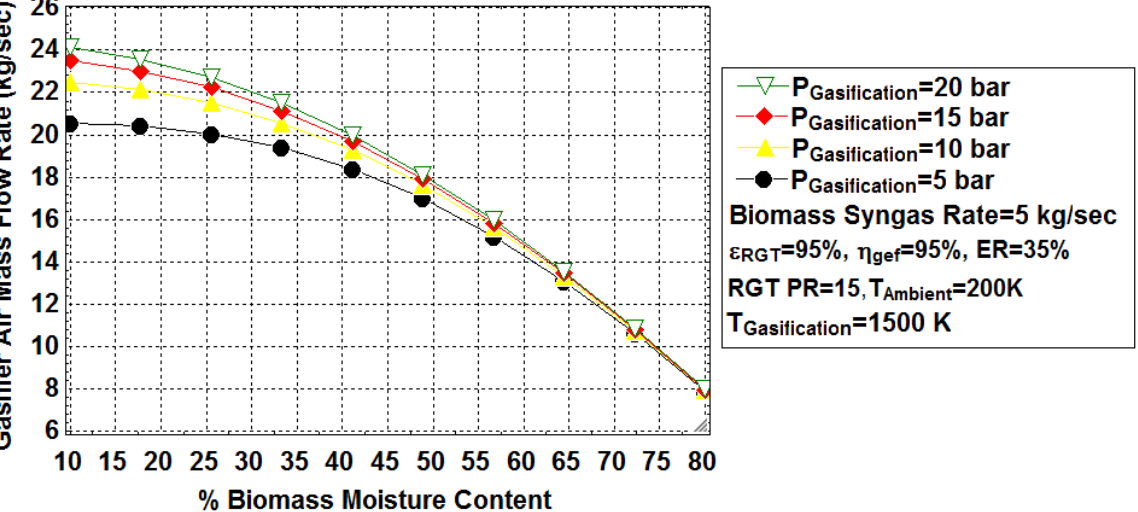
Figure 8. Variation of biomass moisture content with the gasifier’s airflow rate at different gasifica- tion pressures.